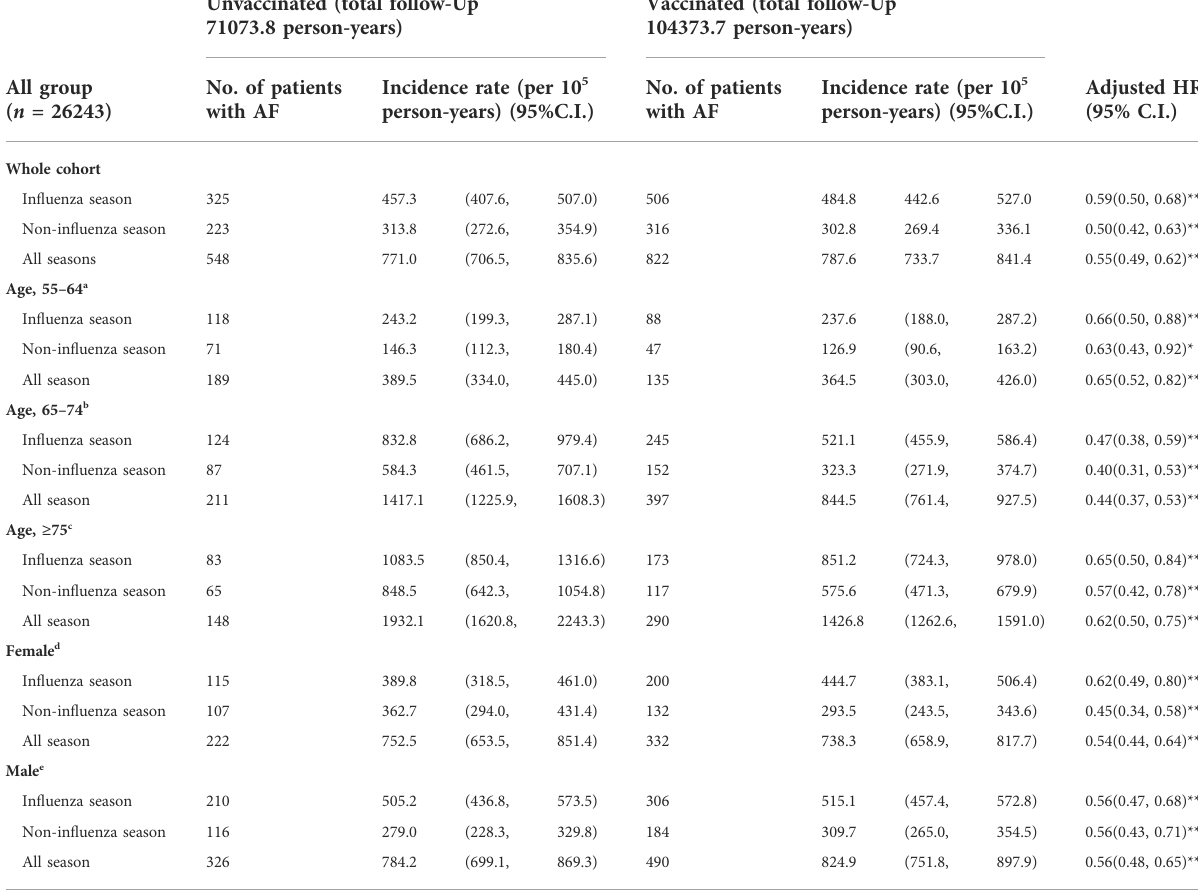
TABLE 2 Risk of atrial fi brillation among unvaccinated and vaccinated in study cohort. Unvaccinated (total follow-Up 71073.8 All group ( n = 26243)